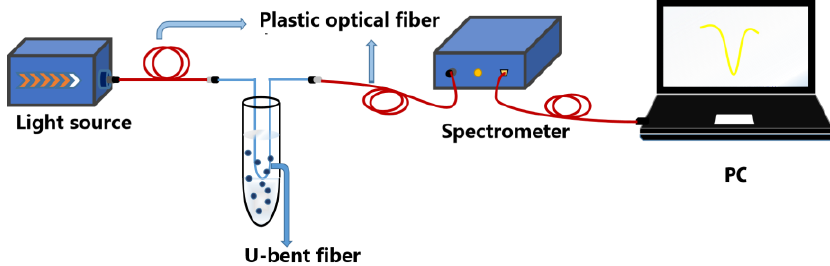
Figure2. Figure 2. The schematic diagram for the experimental set-up used in the U-bent optical fiber LSPR sensor.